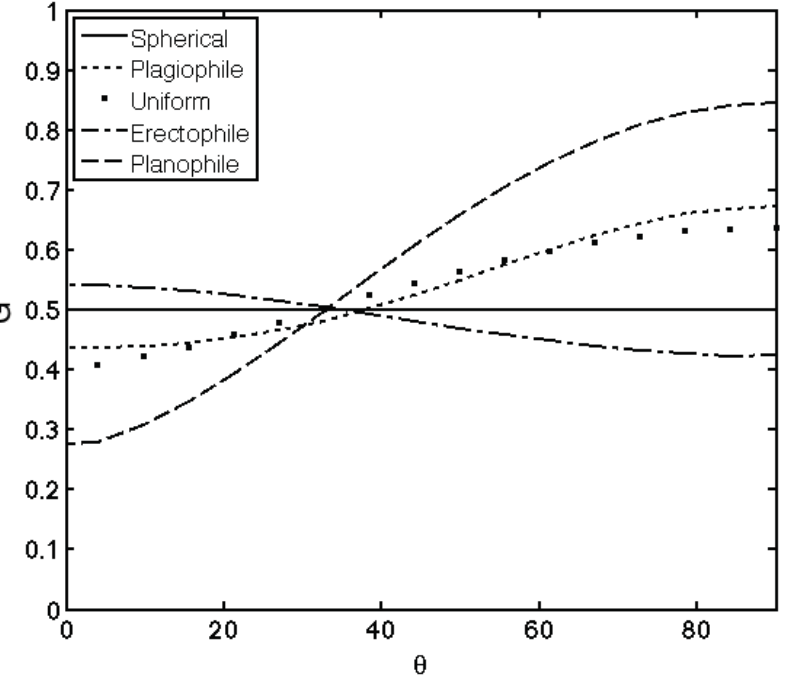
Figure 5. Several projection functions ( G ) of the zenith angle (0 is horizontal; 90° is vertical) used to compute indices I 3